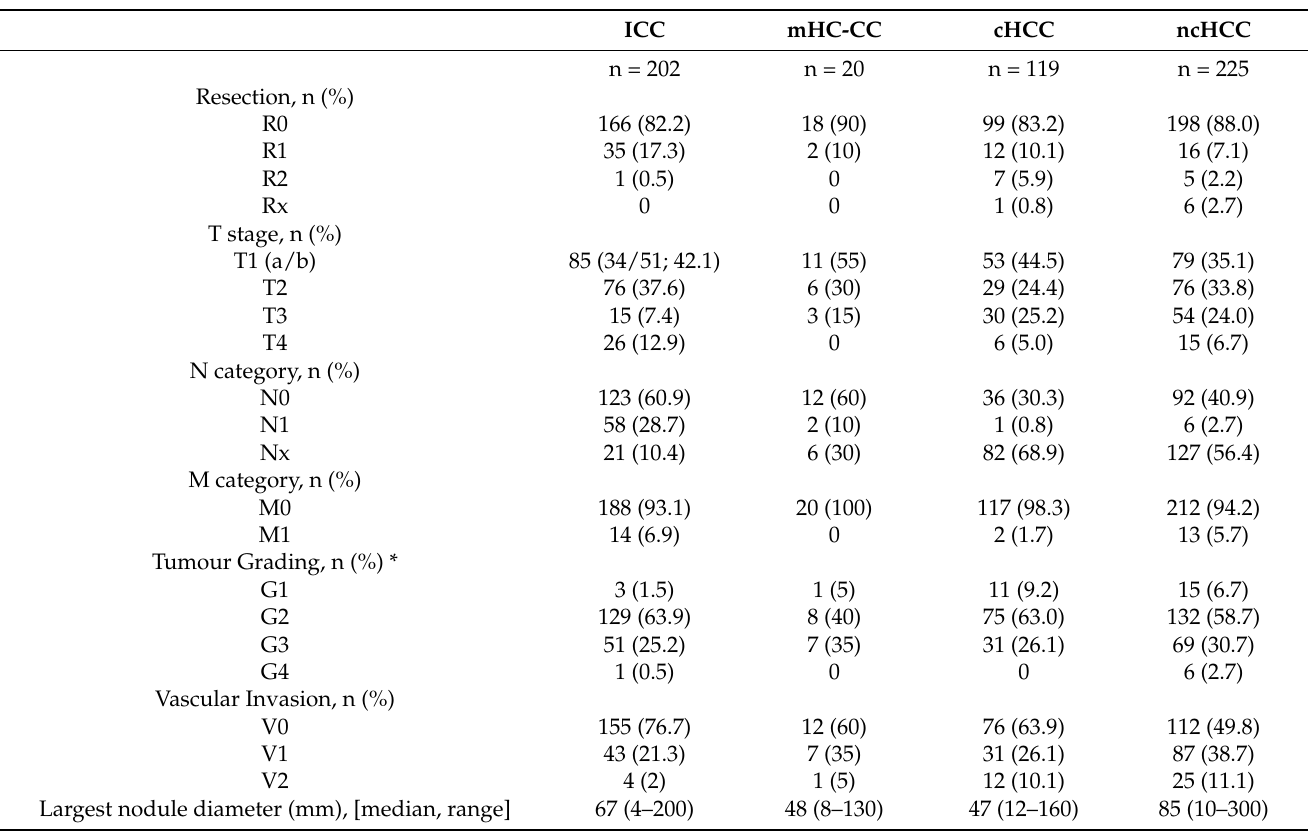
Table 2. Histological outcomes after resection.